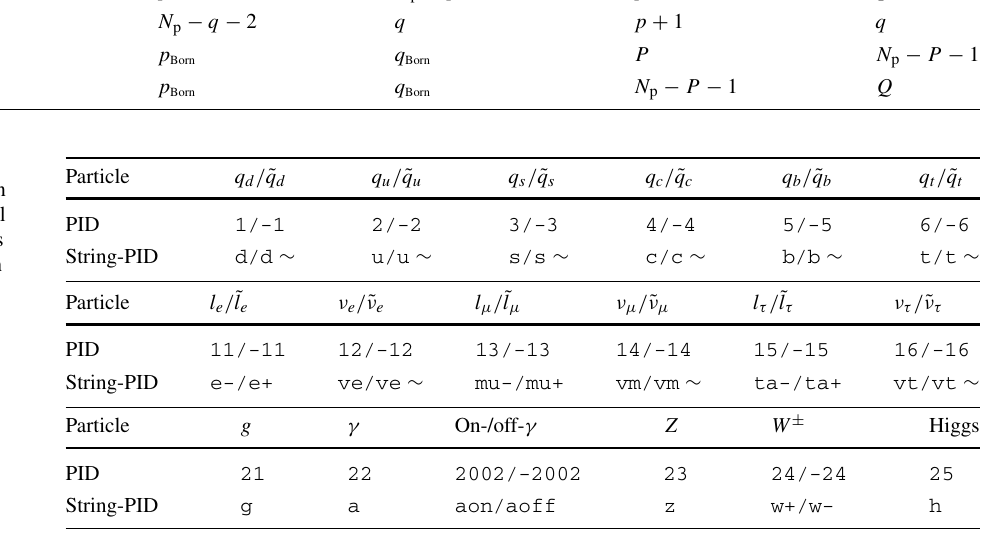
Table 5 Selection of the orders α p s α q and α P s α Q for the LO and NLO objects defined in Table 4. Each selector takes one of the powers p , q , P , Q as input and derives all other powers as indicated in columns 2–5. The QCD and EW coupling powers at LO and NLO are related through p + q = N p − 2 and P + Q = N p − 1, where N p is the number Power selection \ derived powers